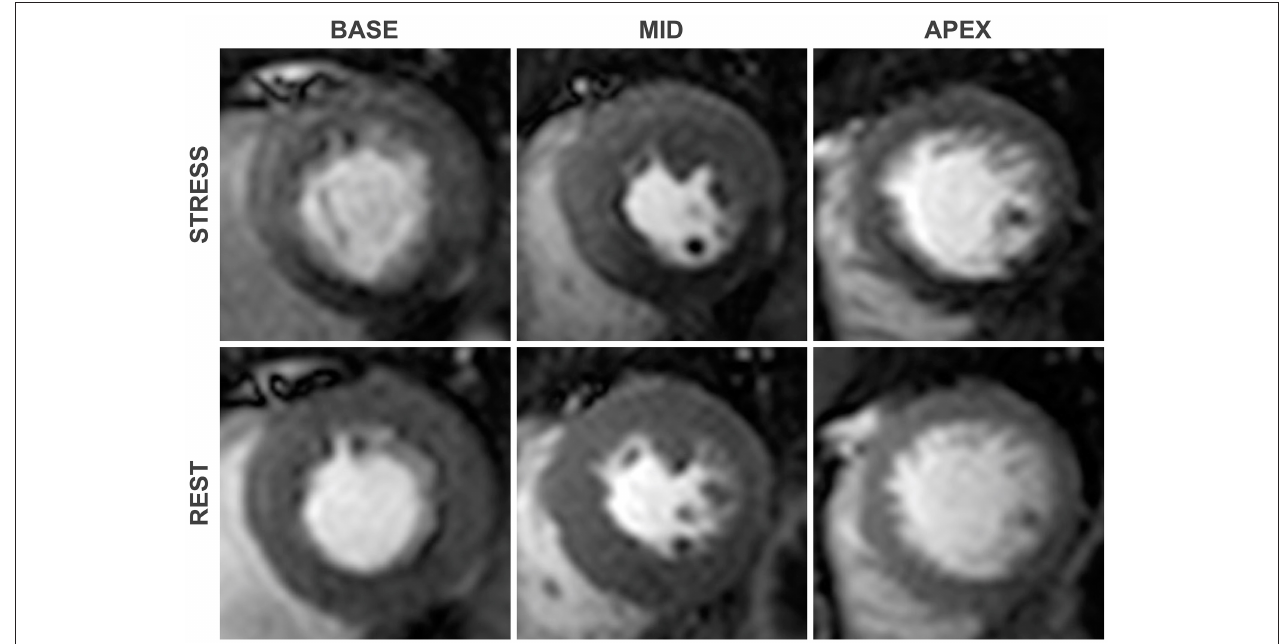
FIGURE 2 | First-pass perfusion images at pharmacologically induced stress (top) and at rest (bottom) . An inducible perfusion defect is seen in the Inferior and inferoseptal segments when compared with the remote segments, consistent with flow limiting disease in the right coronary artery. As is typical of perfusion defects secondary to obstructive coronary stenoses, contrast hypoenhancement is most pronounced in the subendocardial